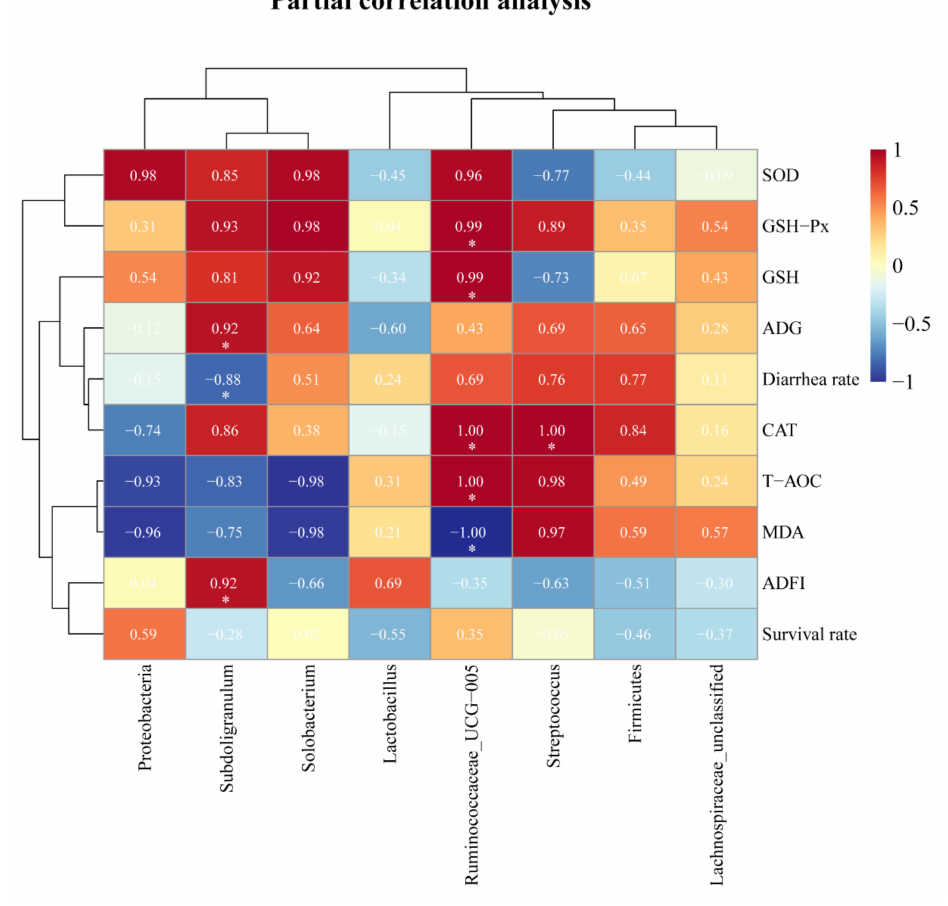
Figure 5. The partial correlation analyses between the differential microbial species and measured parameters. ADG, average daily gain; ADFI, Average daily feed intake; SOD, total superoxide dis- mutase; CAT, catalase; GSH, glutathione; GSH-Px, glutathione peroxidase; T-AOC, total antioxidant capacity; MDA, malondialdehyde; The red represents positive correlation, blue represents negative correlation, and the depth of the color represents the degree of correlation, respectively (Labeled with * indicate significantly different, p <